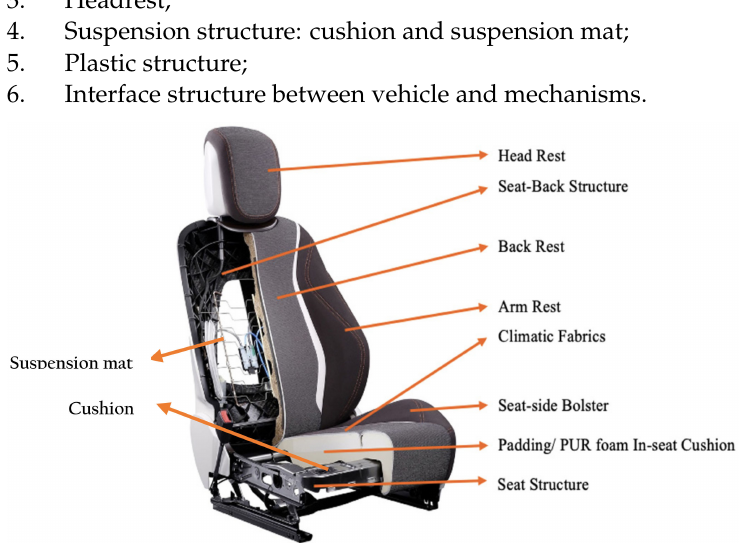
Figure 1. Components of a car seat (adapted from